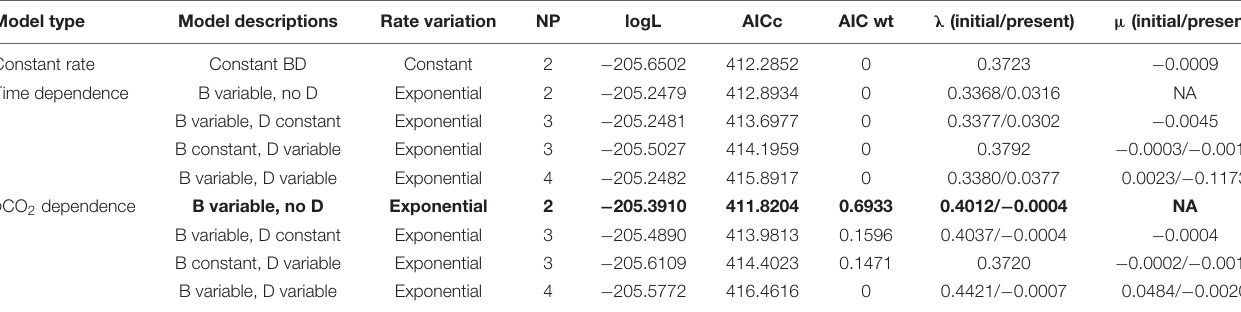
TABLE 2 | Results of diversification analyses for the Cirrhopetalum alliance. Model